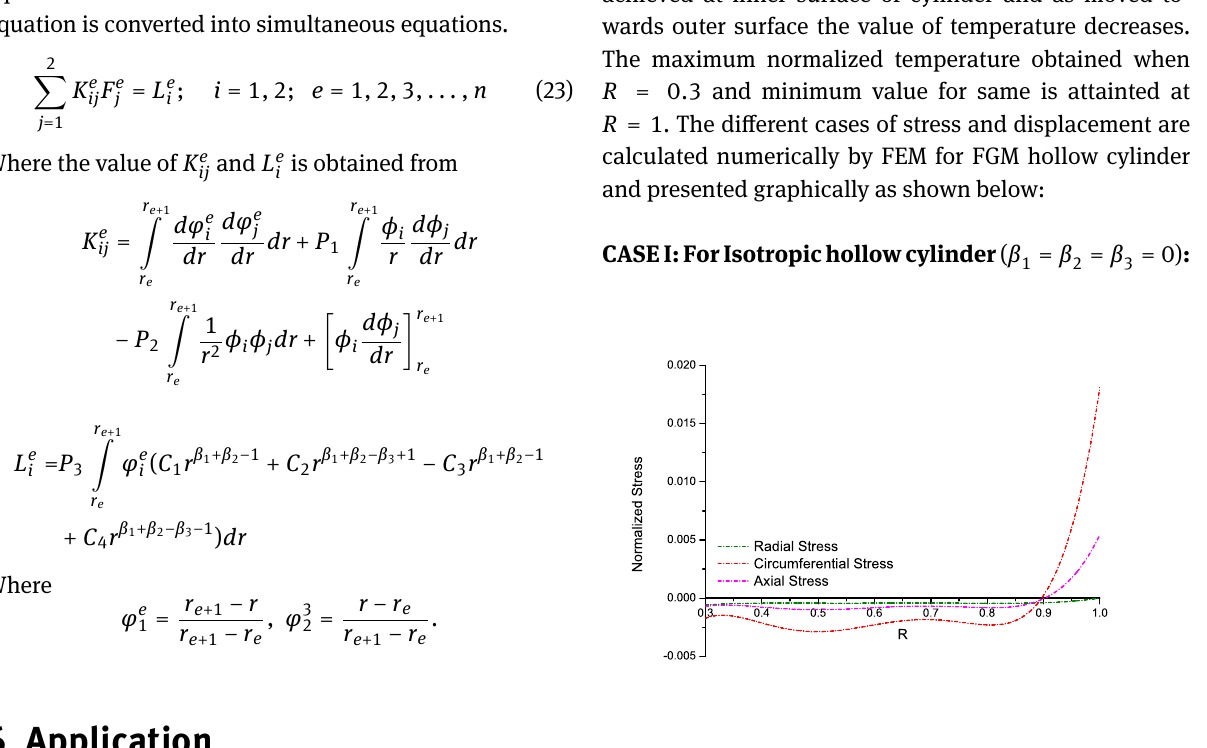
Figure 2: Normalized stresses versus dimensionless radial coordi-